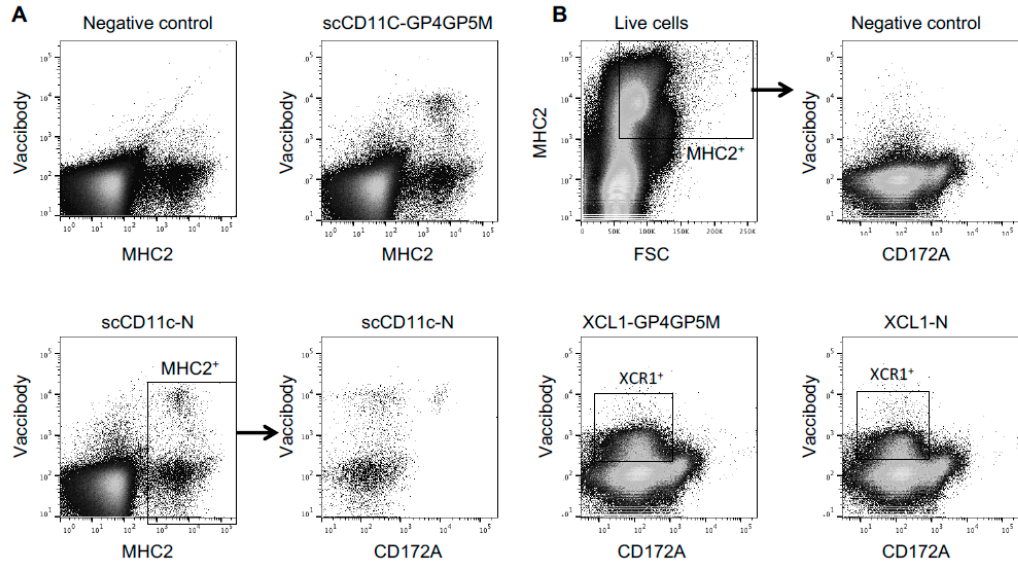
Figure 4. Binding of VB-PRRSV-AGs to whole pig PBMCs and low-density pig PBMCs. ( A ) PBMCs were incubated with about 10 times concentrated supernatants containing scCD11c-N and scCD11c-GP VBs as well as with a negative control concentrated supernatant (cells transfected with pcDNA3.1-ctrl), and the VBs were revealed with anti-CH3 mAb followed by A488-GAM IgM. The cells were co-stained for detection of pig MHC class II (A647) and CD172A (APC-cy7). Dead cells were excluded with DAPI. ( B ) Low-density PBMCs were incubated with about 10 times concentrated supernatants containing XCL1-N, XCL1-GP4GP5M, and with the negative control concentrated supernatant, followed by the same steps as in ( A ).